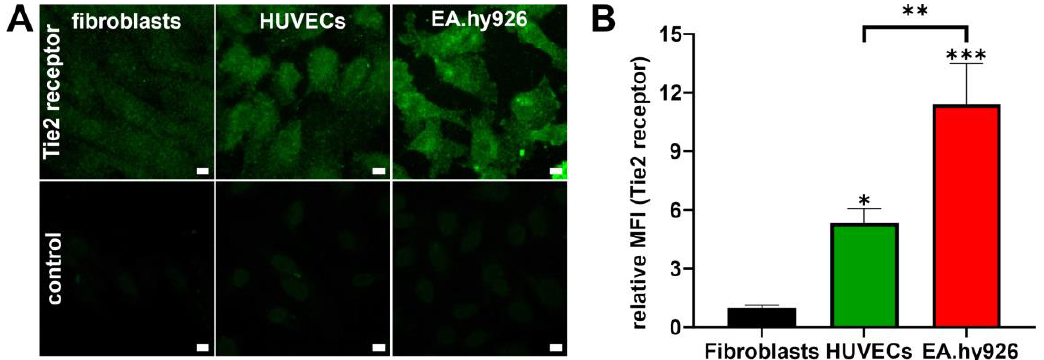
Figure 3. Comparison of Tie2 receptor expression levels. EA.hy926 cells, HUVECs and fibroblasts were analyzed regarding their expression level of the Tie2 receptor. ( A ) Fluorescence immunocyto- chemistry. Upper panels: Representative images of cell-associated Tie2 receptor fluorescence (green, lower panel). After permeabilization, cells were incubated with a primary anti-human Tie2 antibody followed by appropriate Alexa Fluor 488-labeled secondary antibody. EA.hy926 cells showed the highest fluorescence intensity, followed by HUVECs and fibroblasts. Lower panels: Staining with- out primary antibody showed a negligible background fluorescence intensity. Bars indicate 10 µm. ( B ) Flow cytometry analysis of the Tie2 receptor expression levels. Presented is the fold change of the cell-associated mean fluorescence intensity (MFI) of Tie2 receptor compared to fibroblasts. Again, after trypsinization, fixation and permeabilization, cells were incubated with a primary anti- human Tie2 antibody followed by appropriate Alexa Fluor 488-labeled secondary antibody. Tie2 receptor-derived fluorescence was excited at 488 nm and the emission was detected using a 660/20 nm bandpass filter. EA.hy926 cells showed a 11-fold higher and HUVECs a 5-fold higher MFI com- pared to fibroblasts. Results are presented as mean ± SD of at least n = 3 measurements. * p < 0.05, ** p < 0.01, *** p < 0.001.